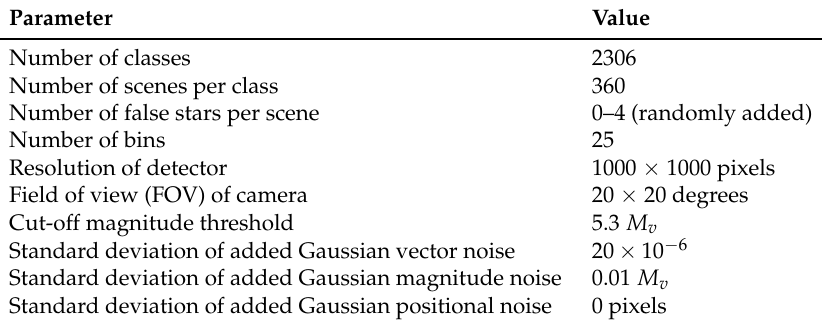
Table 1. Training dataset parameters.